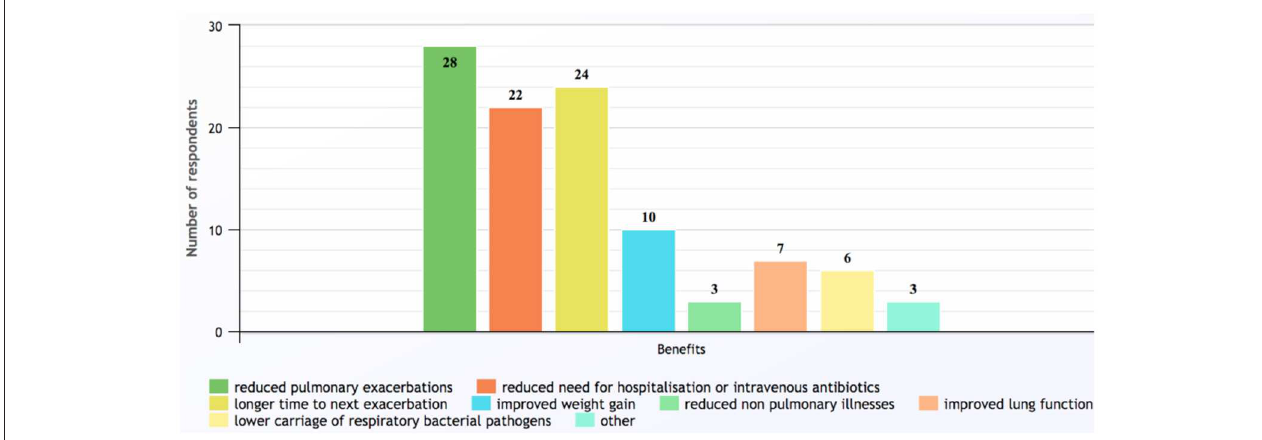
FIGURE 3 | Benefits of long-term azithromycin reported by survey respondents. Other responses included: unsure; improved asthma control; and better quality of life (response to